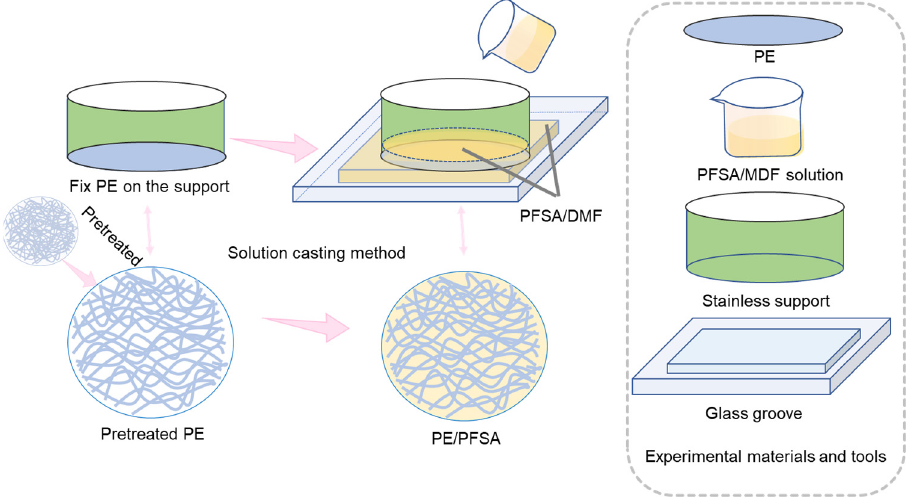
Figure 1. Schematic illustration of process for fabricating the PE/PFSA composite membrane.